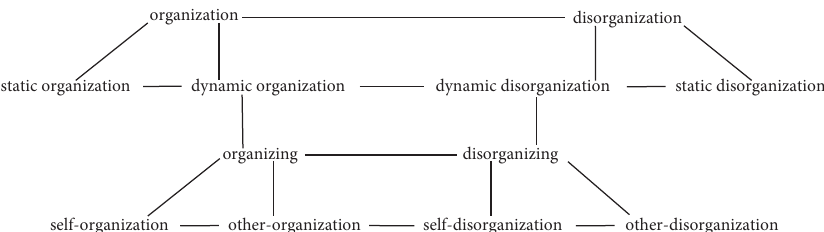
Figure 1: Conceptual systems of organization and Figure 1 represents this four-level structure. The con- nections indicate the complementarity, compatibility, and transformation between links.